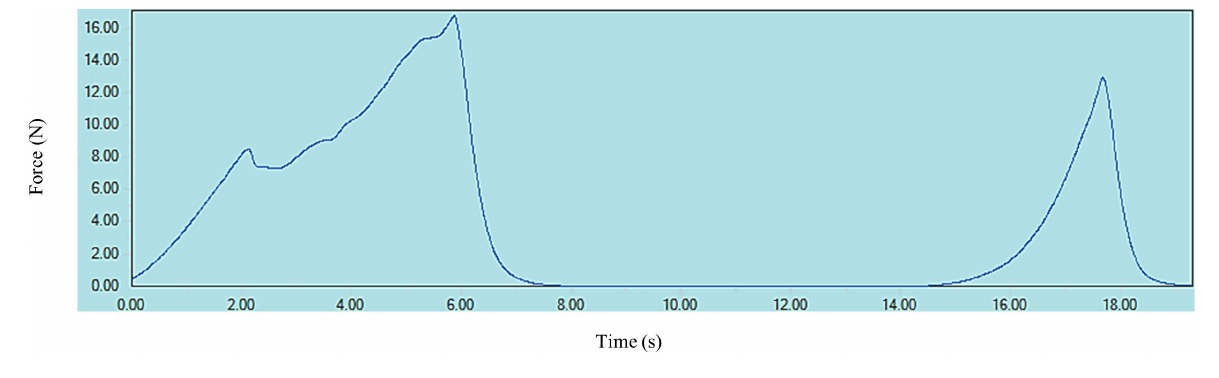
chickpeas with increase in pressure (from 100 to 400 MPa).